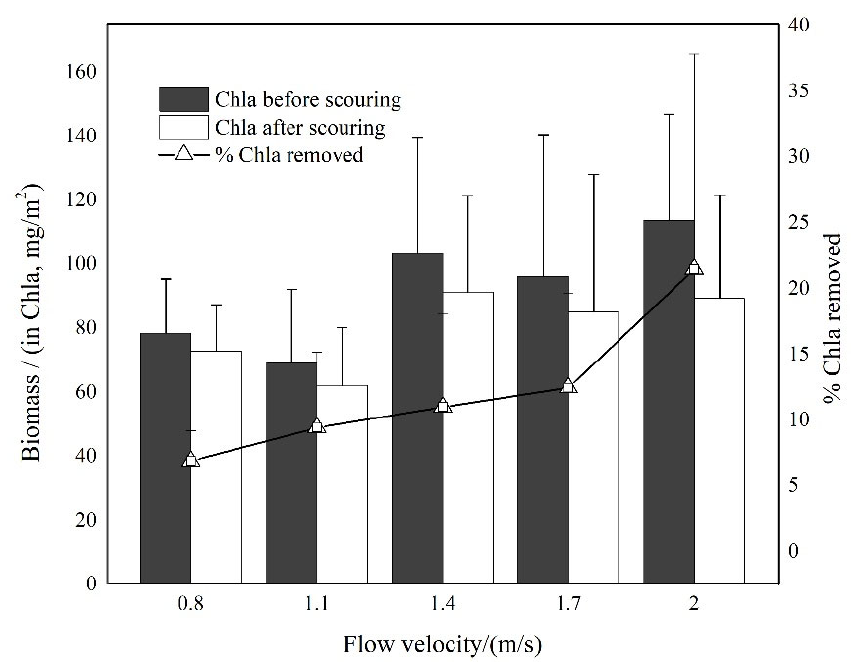
Figure 5. Variation of the biomass of benthic algae (in chlorophyll a per unit area, mean + SD) before and after scouring by different flow velocities, 0.8, 1.1, 1.4, 1.7, and 2.0 m/s.